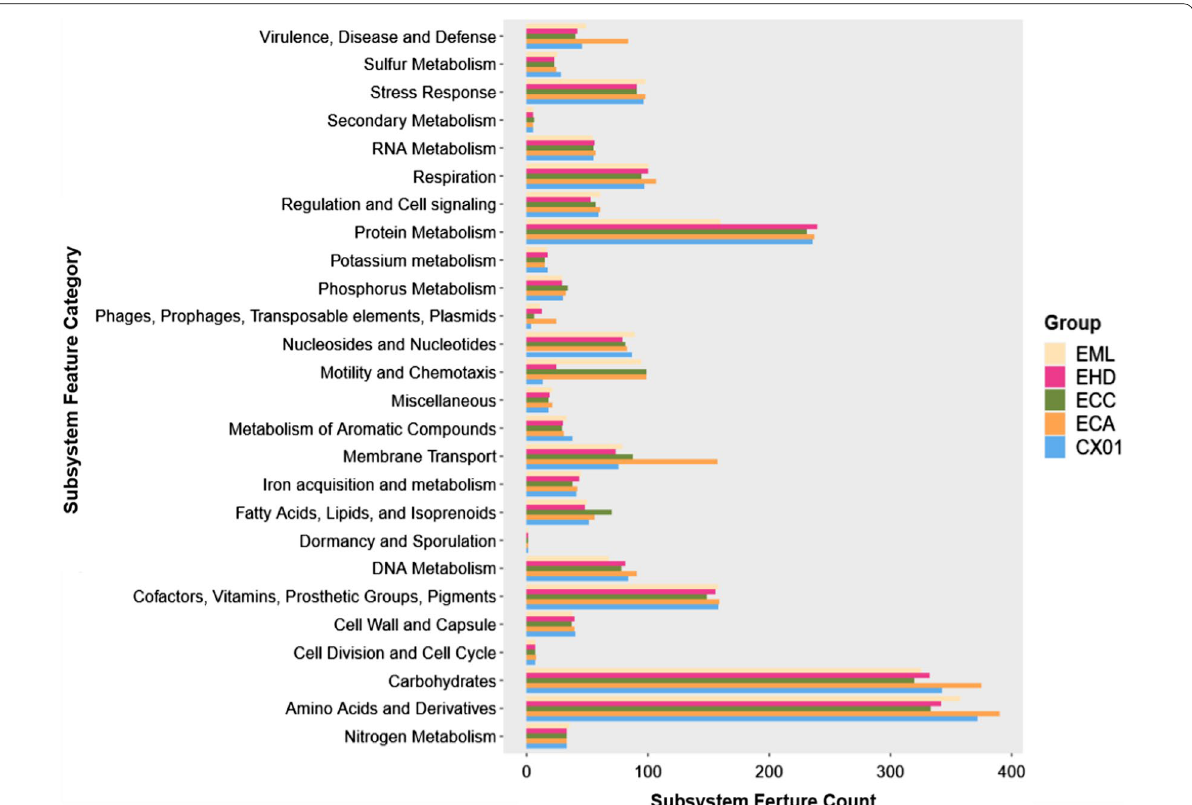
Fig. 5 Comparison of subsystem features among Enterobacter species. The data are derived from genome information of E. mori LMG 25706 (EML), E. mori CX01 (CX01, CP055276), E. cloacae ATCC 13047 (ECA, NC_014121.1), E. hormaechei DSM 16691 (EHD, NZ_CP017179.1) and E. cancerogenus CR-Eb1 (ECC,